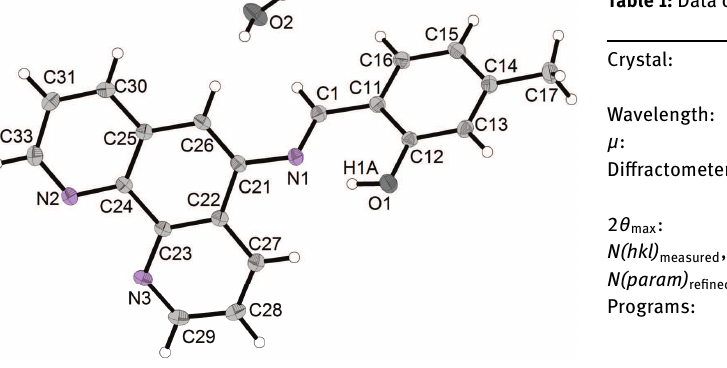
Table 1: Data collection and handling.